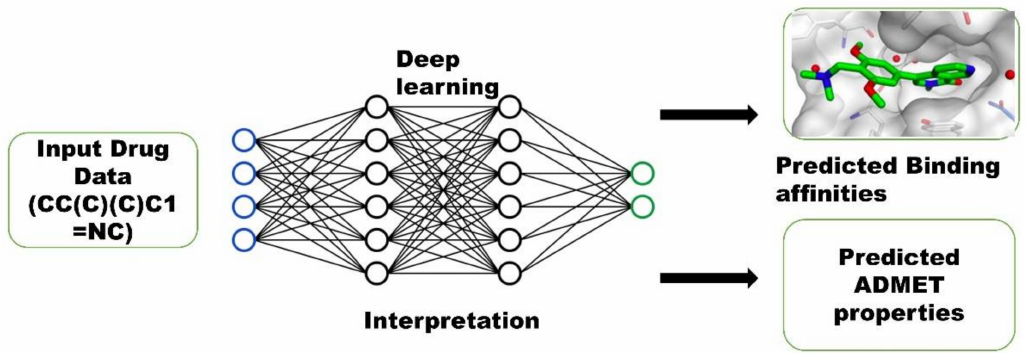
Figure 2. Implementation of Deep learning